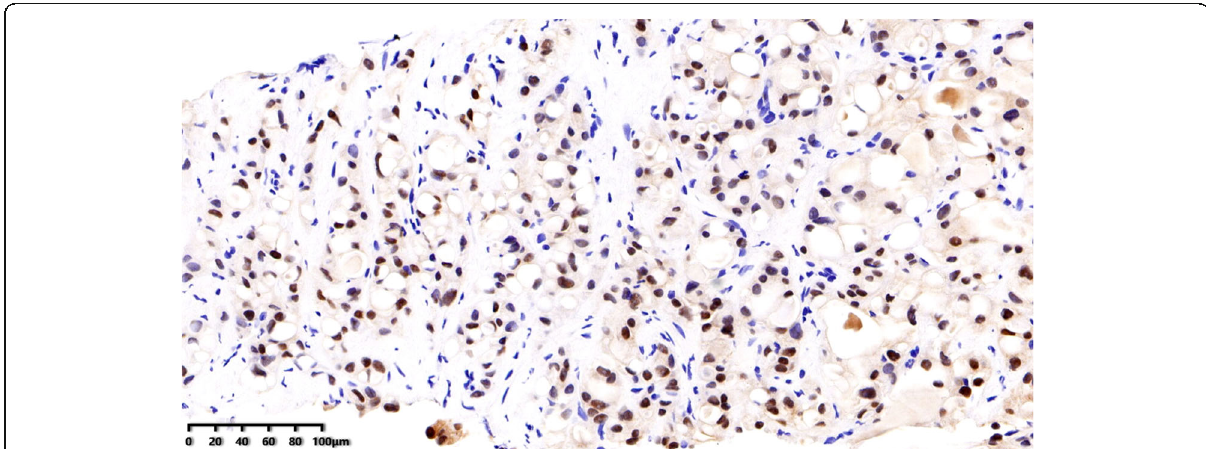
Fig. 4 Tumor cells were positive for pan-TRK. IHC